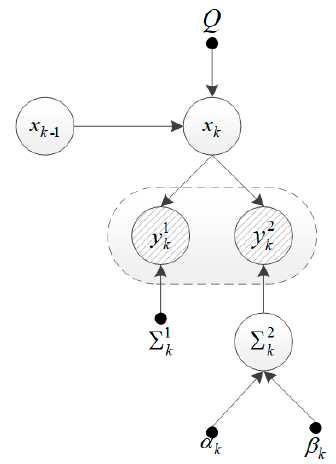
Figure 2. Probabilistic graphical model representation of our model.